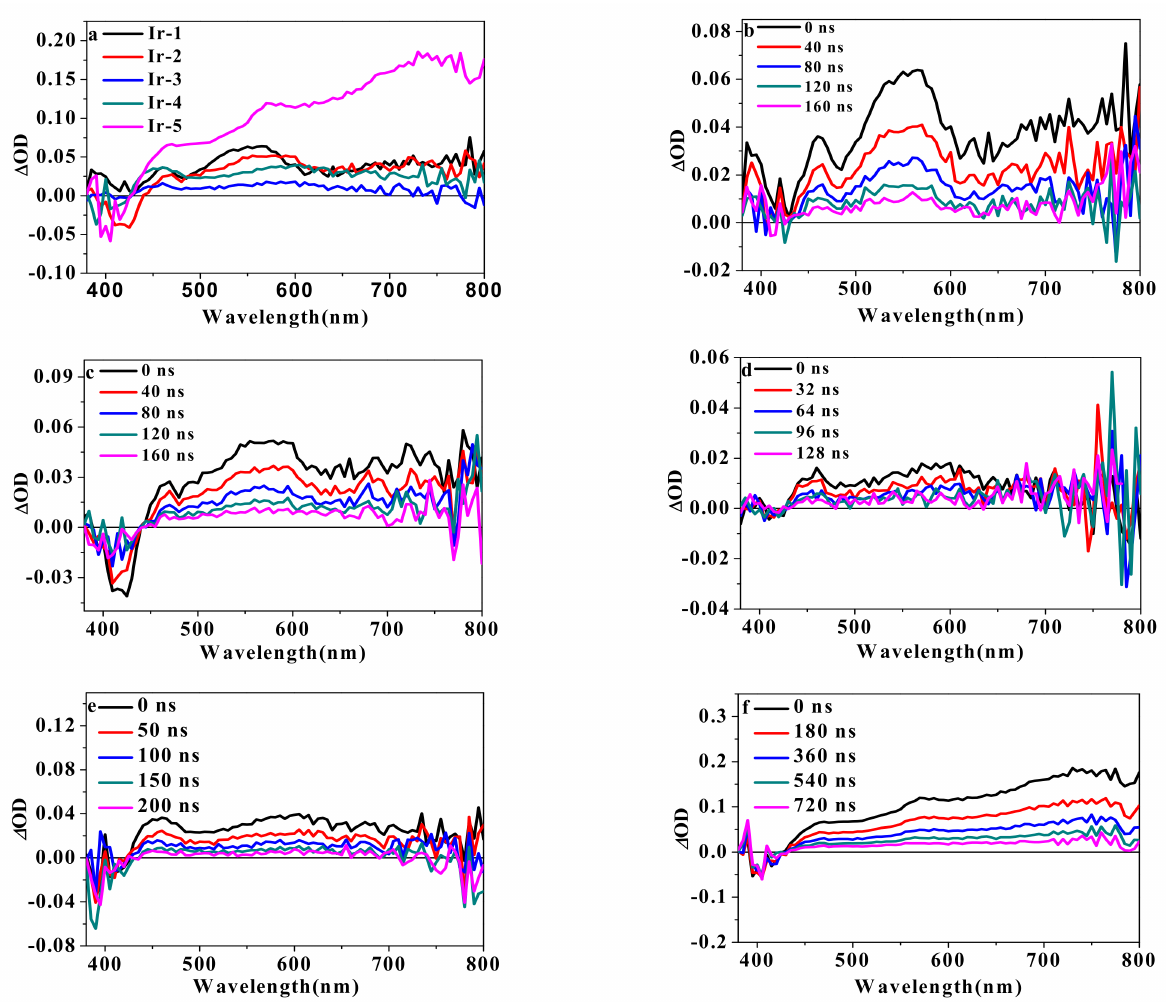
Figure 3. ( a ) Nanosecond transient difference absorption spectra of Ir-1 – Ir-5 in CH 3 CN at zero- time decay; ( b – f ) time-resolved TA spectra of Ir-1–Ir-5 . The spectra were all measured in CH 3 CN, ( λ ex = 355 nm, A 355 = 0.4 in a 1 cm